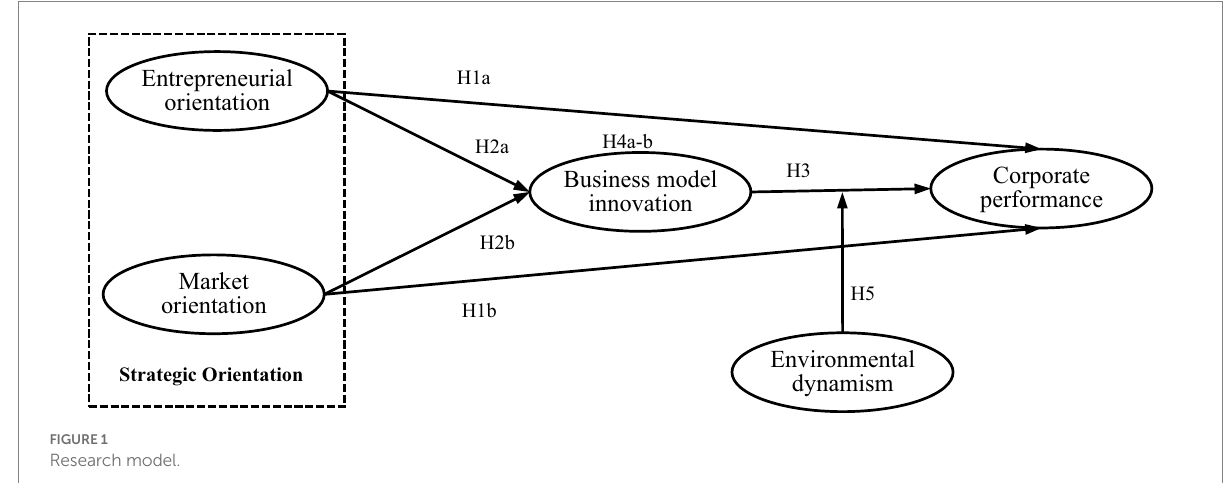
FIGURE 1 Research